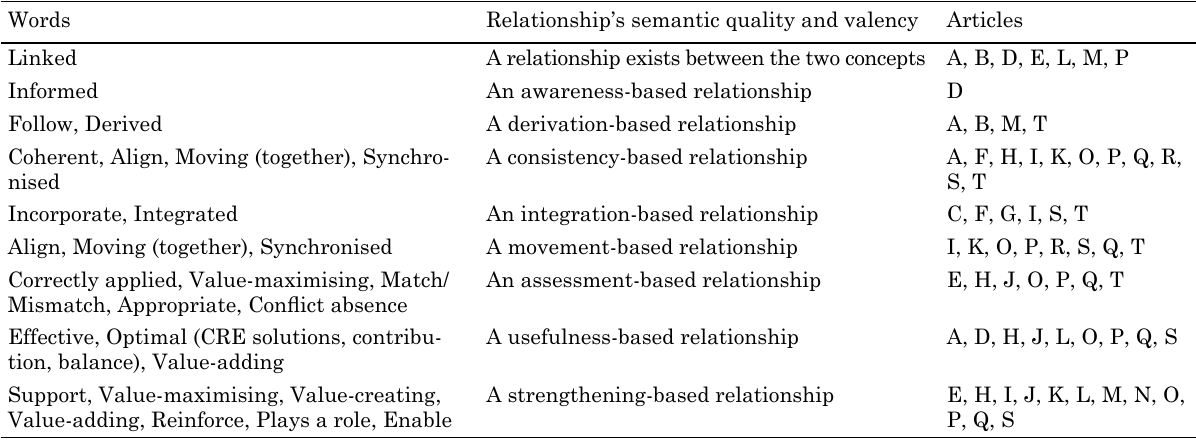
Table 1. ‘Alignment’ words and their relationships’ semantic quality Words Relationship’s semantic quality and